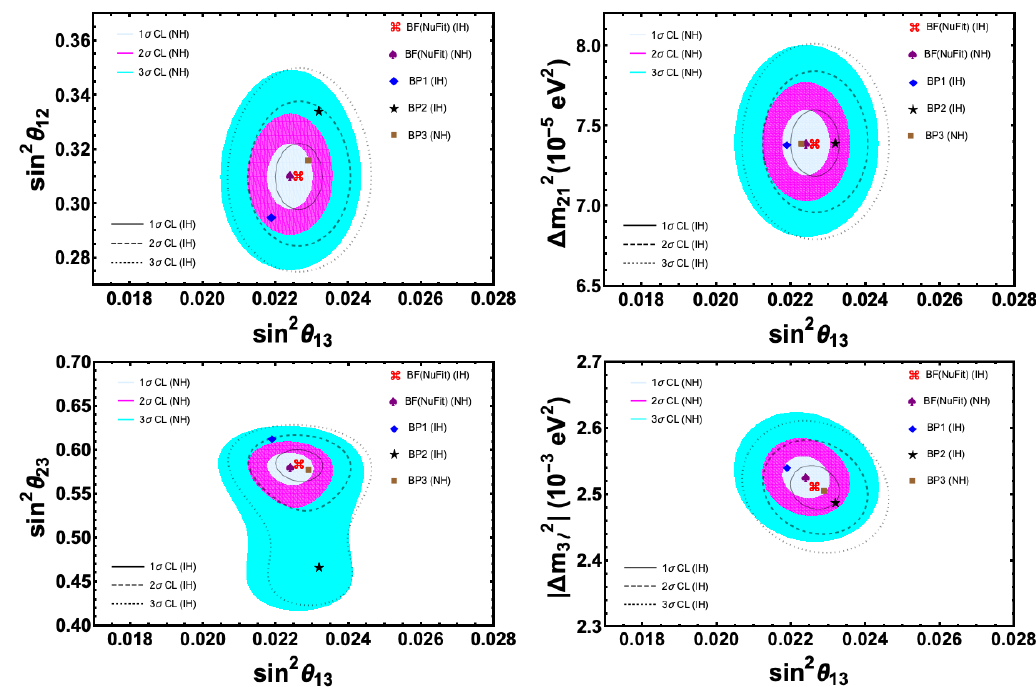
Figure 21 . Global oscillation analysis obtained from NuFit4 [159] for both Normal hierarchy (NH) and Inverted hierarchy (IH) compared with our model benchmark points (BP1, BP2, BP3). Gray, Magenta, and Cyan colored contours represent 1 (cid:27); 2 (cid:27); and 3 (cid:27) CL contours for NH, whereas solid, dashed, and dotted lines respectively correspond to 1 (cid:27); 2 (cid:27); and 3 (cid:27) CL contours for IH. Red, purple, and (blue, black, brown) markers are respectively best-(cid:12)t from NuFit for IH and NH, and benchmark points I, II and III for Yukawa structures given in eqs.